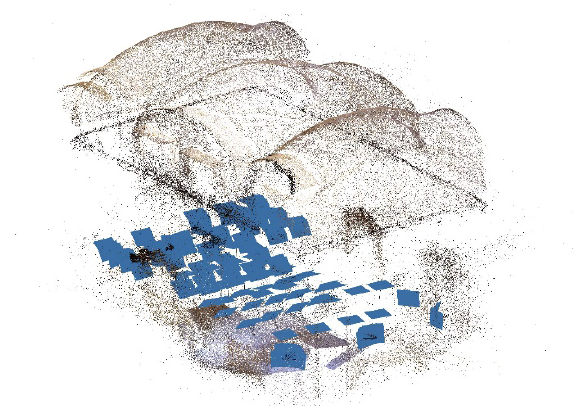
Figure 8. Textured mesh model from PhotoScan - ‘Prima Anticamera’ (Modelling: F. Natta)